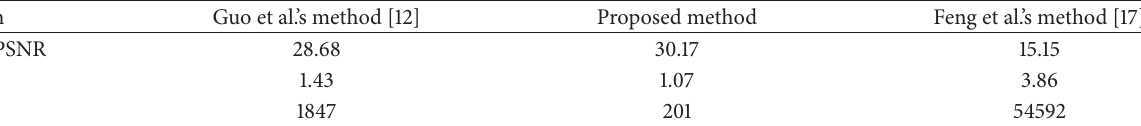
Table 5: Quality comparisons of various algorithms with 64 × 64 watermark bits embedded in Figure 8(a).